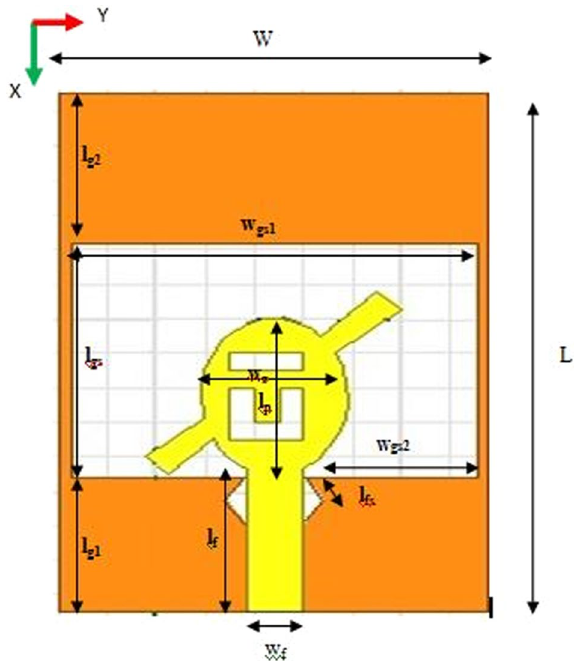
Fig. 2 Proposed UWB antenna